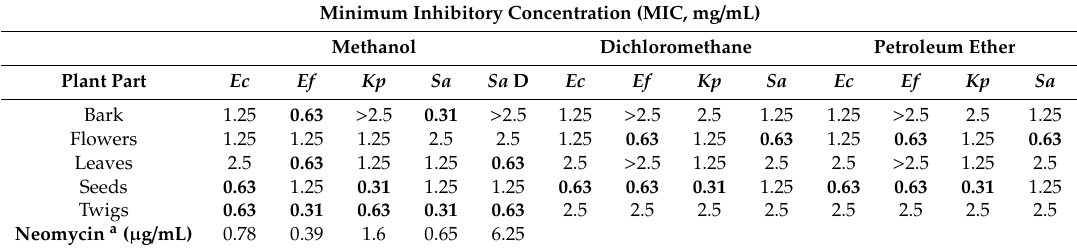
Ec = Escherichia coli ; Ef = Enterococcus faecalis ; Kp = Klebsiella pneumoniae ; Sa = Staphylococcus aureus , Sa D = Penicillin-resistant S . aureus . MIC values bold-written indicate noteworthy antibacterial activity. a = Positive control. Table 2. Minimum inhibitory concentration (MIC, mg / mL) values of fractions obtained from a methanol extract of Protea ca ff ra twigs.